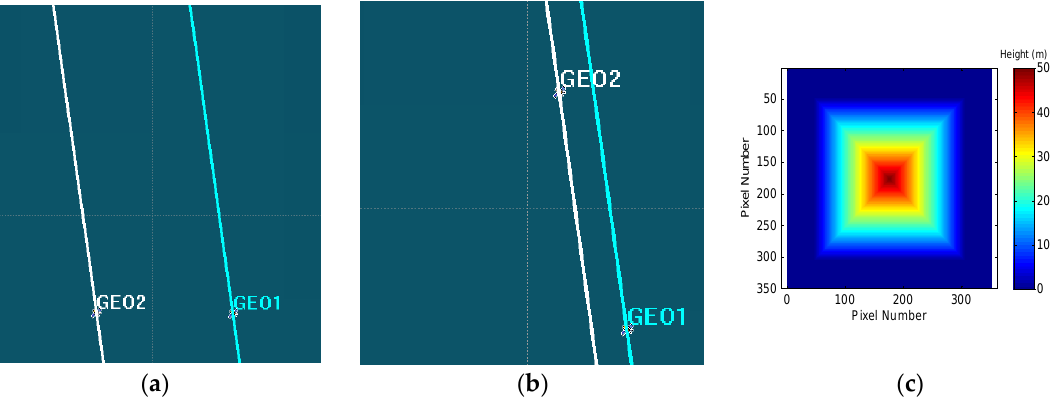
Figure 9. Formation design results and DEM setting. ( a ) Formation designed by the proposed method; ( b ) Formation designed according to ECI-RME; ( c ) DEM setting for simulation.